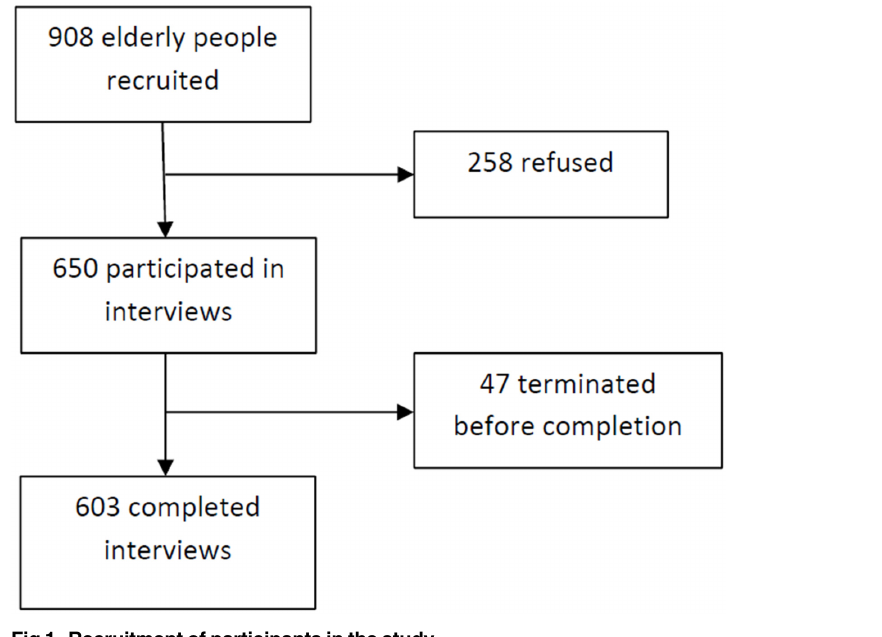
Fig 1. Recruitment of participants in the study